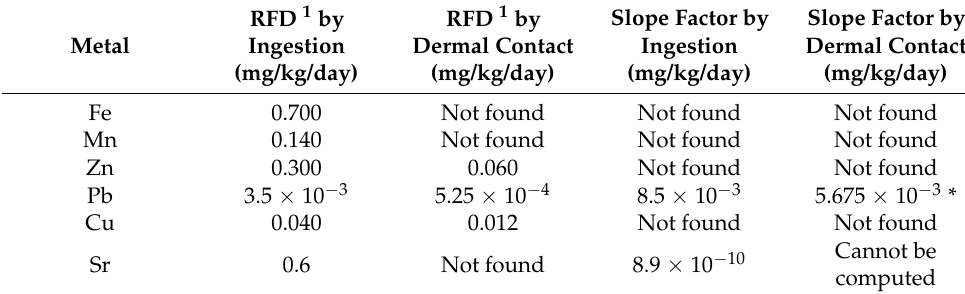
Table 3. RFD and SF values for heavy metals